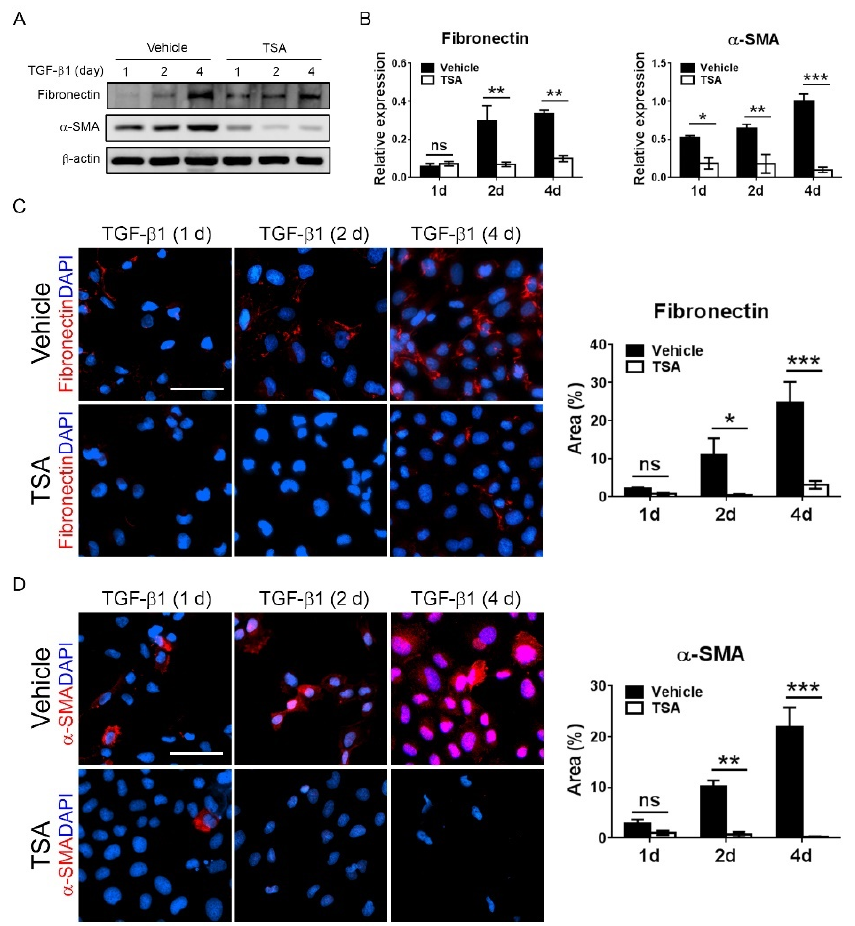
Figure 6. The e ff ect of trichostatin A (TSA) on the activation of renal myofibroblasts. ( A ) Western blots of fibronectin and α -smooth muscle actin (a-SMA) expressions in transforming growth factor- β 1 (TGF- β 1, 20 ng / mL)-stimulated renal tubular epithelial NRK-52E cells at the indicated time. β -actin served as the loading control. ( B ) Quantification for the levels of indicated proteins. * p < 0.05, ** p < 0.01 and *** p < 0.001 by ANOVA, followed by Tukey’s post hoc multiple comparison test. ns, nonsignificance. n = 3 for each group. ( C,D ) Immunofluorescent staining of fibronectin and α -SMA in the TGF- β 1-treated NRK-52E cells at the indicated time. Scale bar = 50 µ m. * p < 0.05, ** p < 0.01 and *** p < 0.001 by ANOVA, followed by Tukey’s post hoc multiple comparison test. ns, nonsignificance. n = 3 for each group.